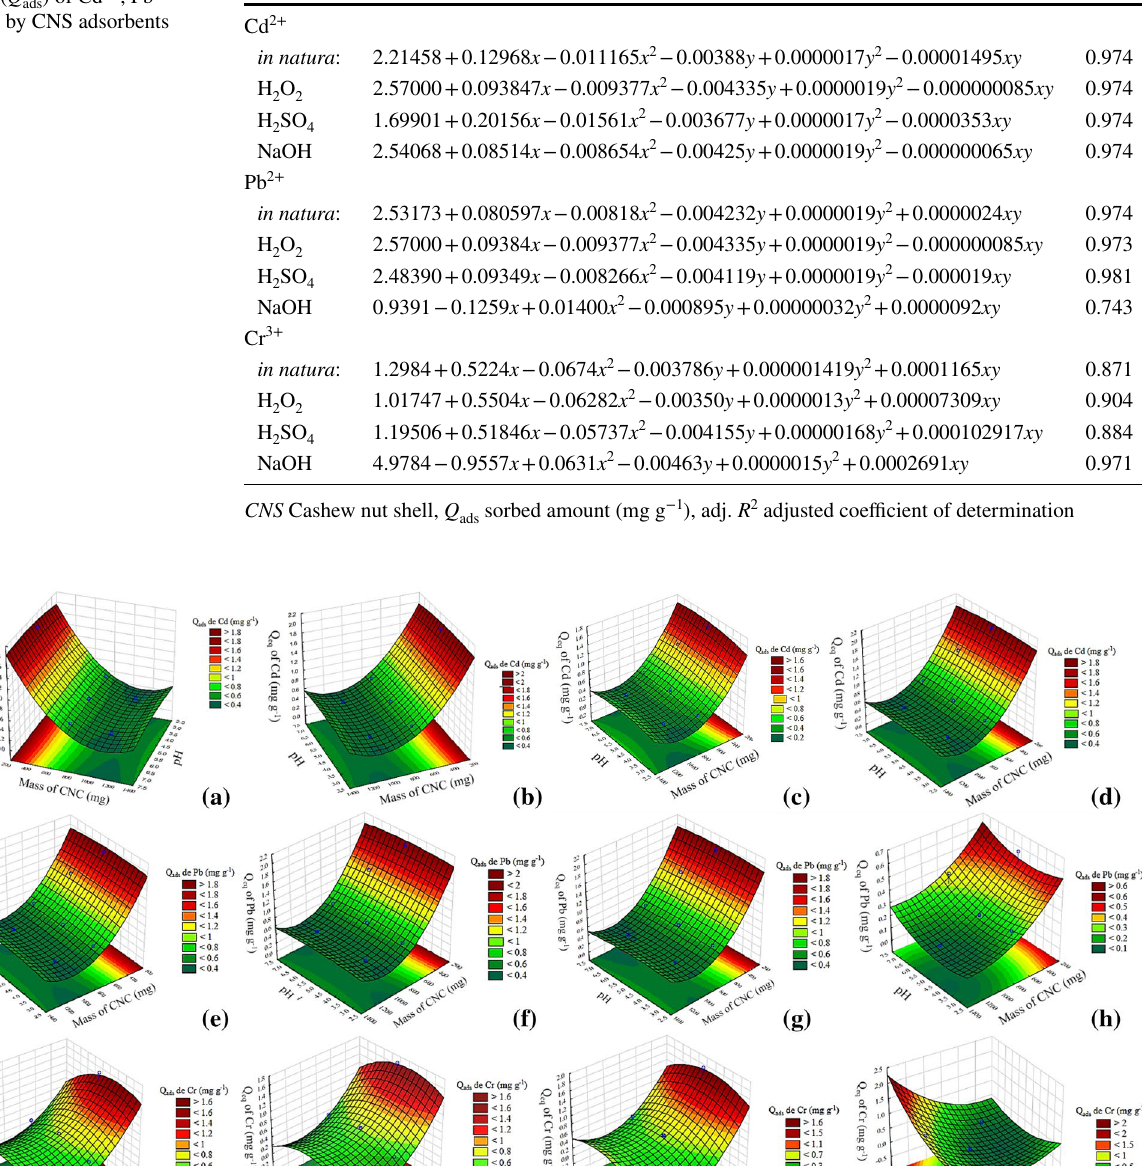
Fig. 7 Graph of response surface for multivariate analysis for adsorbent masses and pH of the solution by the amount adsorbed ( Q ( a – d ), Pb 2+ ( e – h ) and Cr 3+ ( i – l ) on the shell of cashews (CNS) in natura , modified with H 2 O 2 ( b ), H 2 SO 4 ( c ) and NaOH ( d